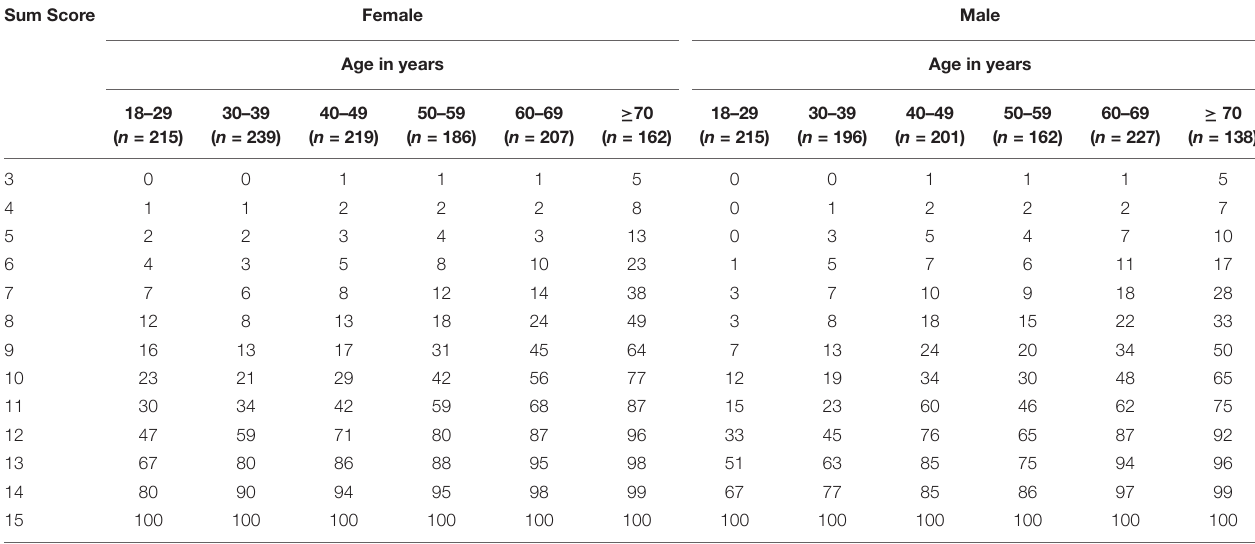
TABLE 7 | Normative percentile ranks for the VBD real version.